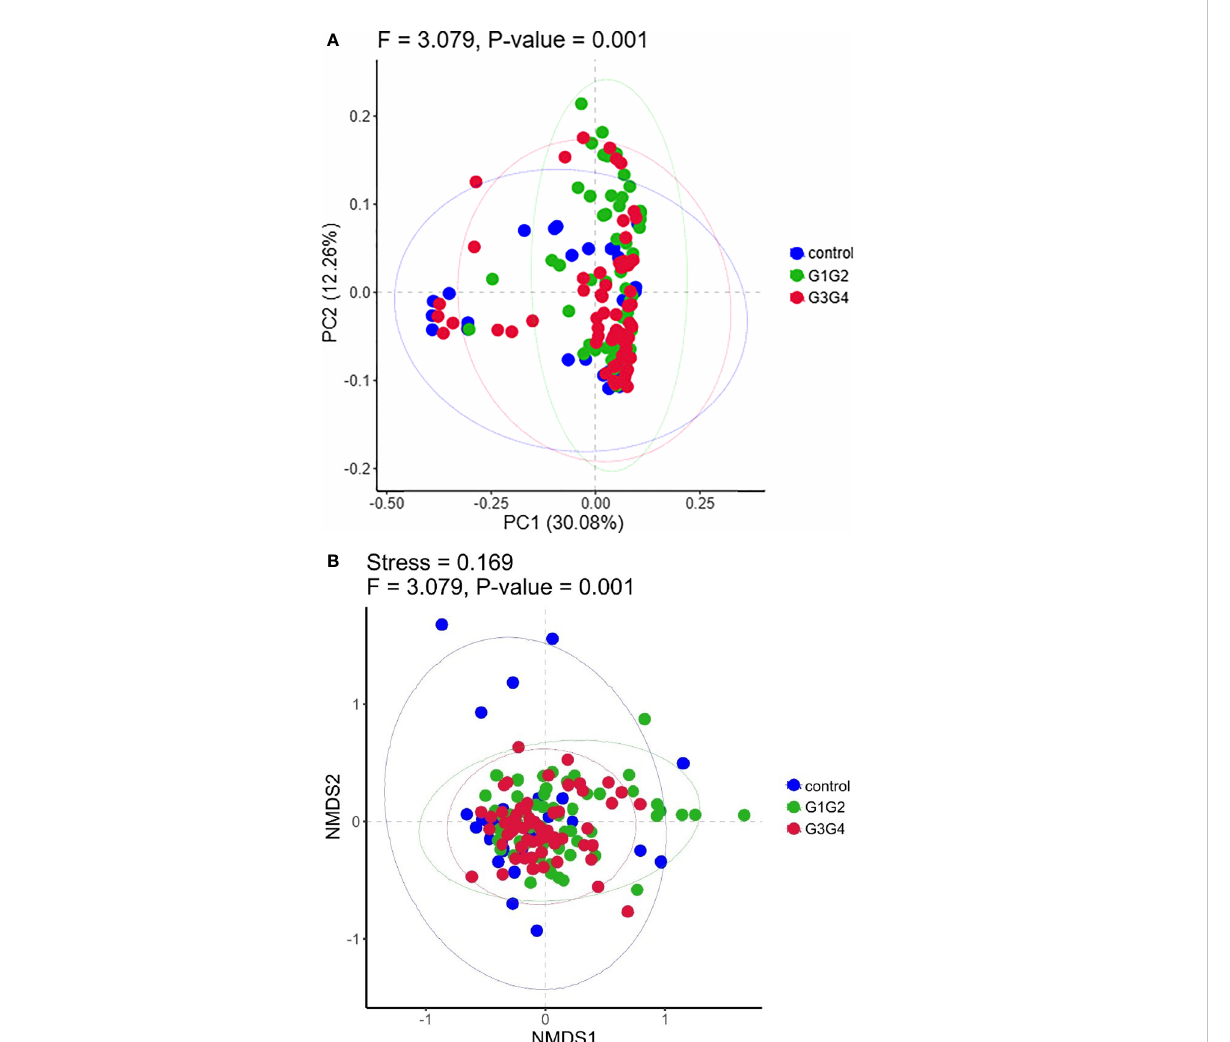
FIGURE 2 (A) Principal Coordinates Analysis (PCoA) plot based on Bray-Curtis distance. Each dot represents one sample from each group and samples from the same group are represented using the same color. (B) The non-metric multidimensional scaling (NMDS) analysis was used to compare the differences between the groups in the sample. Each dot represents one sample from each group, the distance between dot indicates the degree of variation and samples from the same group are represented using the same